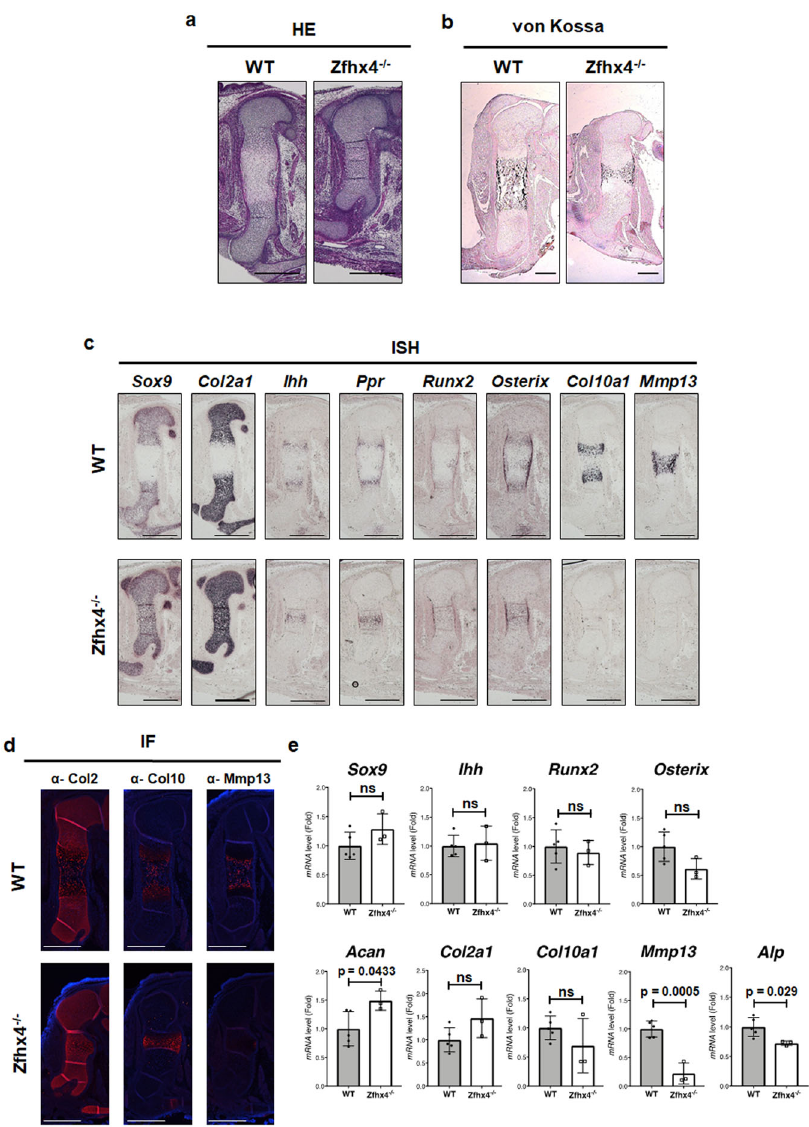
Fig. 2 Delayed endochondral ossi fi cation and downregulation of Mmp13 expression in Zfhx4-de fi cient mice. a Hemolysin and eosin (HE)-stained femurs of E15.5 wild-type (WT) and Zfhx4 − / − littermates. Scale bar = 500 μ m. b Von Kossa-stained femurs of E16.5 WT and Zfhx4 − / − littermates. Scale bar = 200 μ m. c Expression of chondrogenic gene markers in Zfhx4 − / − mice. Paraf fi n-embedded sections of femurs from E15.5 WT and Zfhx4 − / − littermates were examined by in situ hybridization using anti-sense probes against Sox9, Col2a1, Ihh, Ppr, Runx2, Osterix, Col10a1 , and Mmp13 . Scale bar = 500 μ m. d Immuno fl uorescence analysis of femurs from E15.5 WT and Zfhx4 − / − littermates using anti-Col2, anti-Col10, and anti-Mmp13 antibodies. Scale bar = 500 μ m. e mRNA expression levels of chondrocyte marker genes. mRNA isolated from humeri of E15.5 WT and Zfhx4 − / − littermates